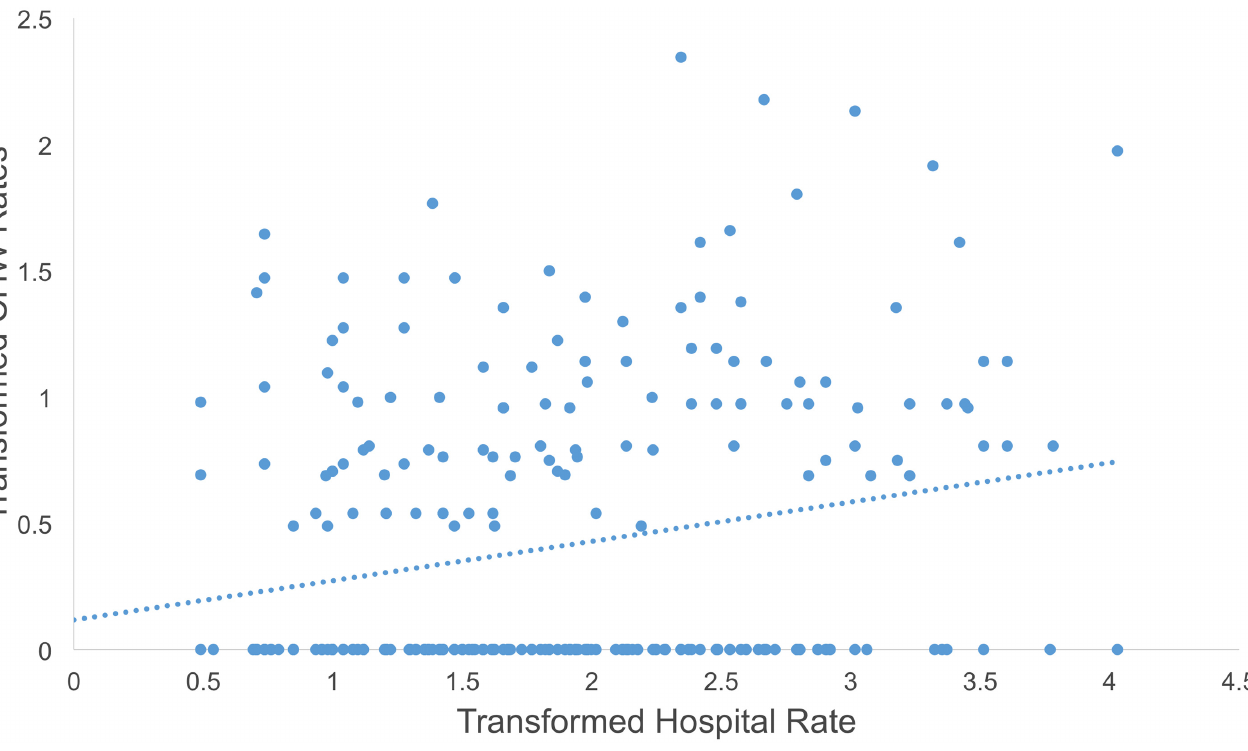
Fig 2. Scatter plot of hospital ARI rate per 1,000 people against community health ARI rate per 1,000 people.